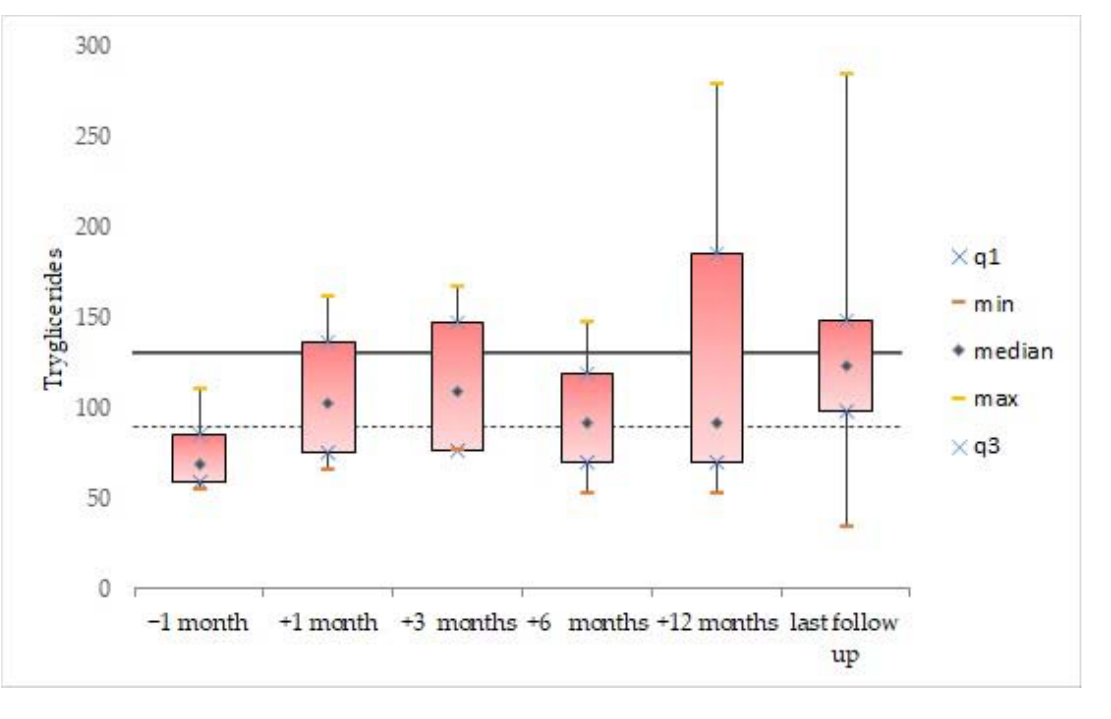
Figure 2. Triglyceride levels before and during vemurafenib. The dashed line indicates the acceptable upper limit, the double line indicates the borderline-high limit according to the NCEP Expert Panel on Cholesterol Levels in Children.